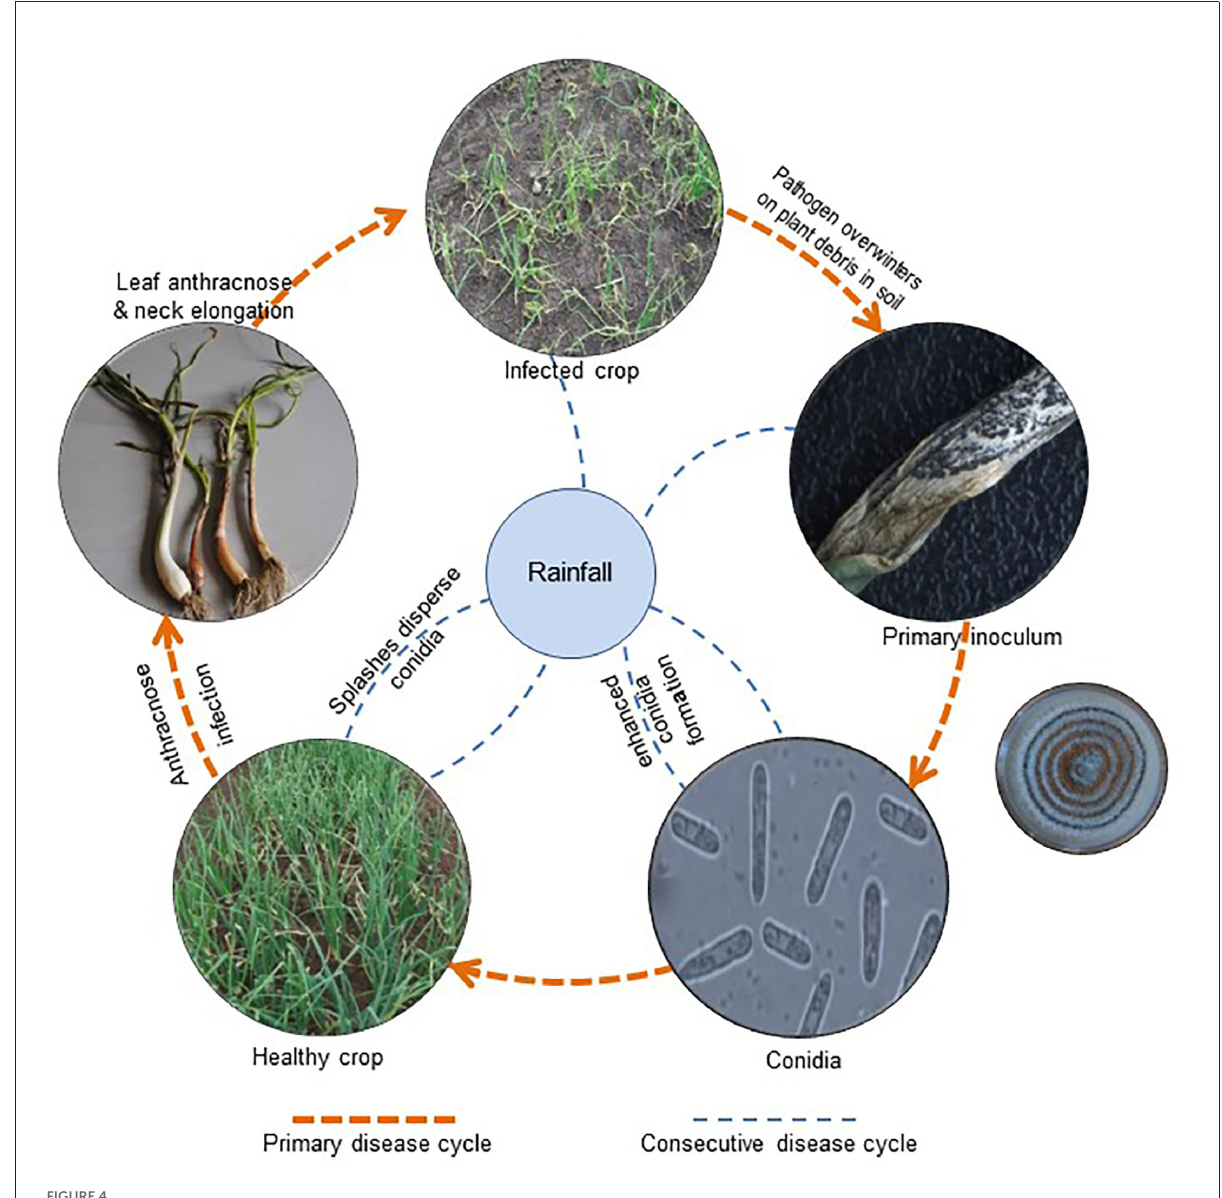
FIGURE4 Disease cycle of C. gloeosporiodes on Allium cepa